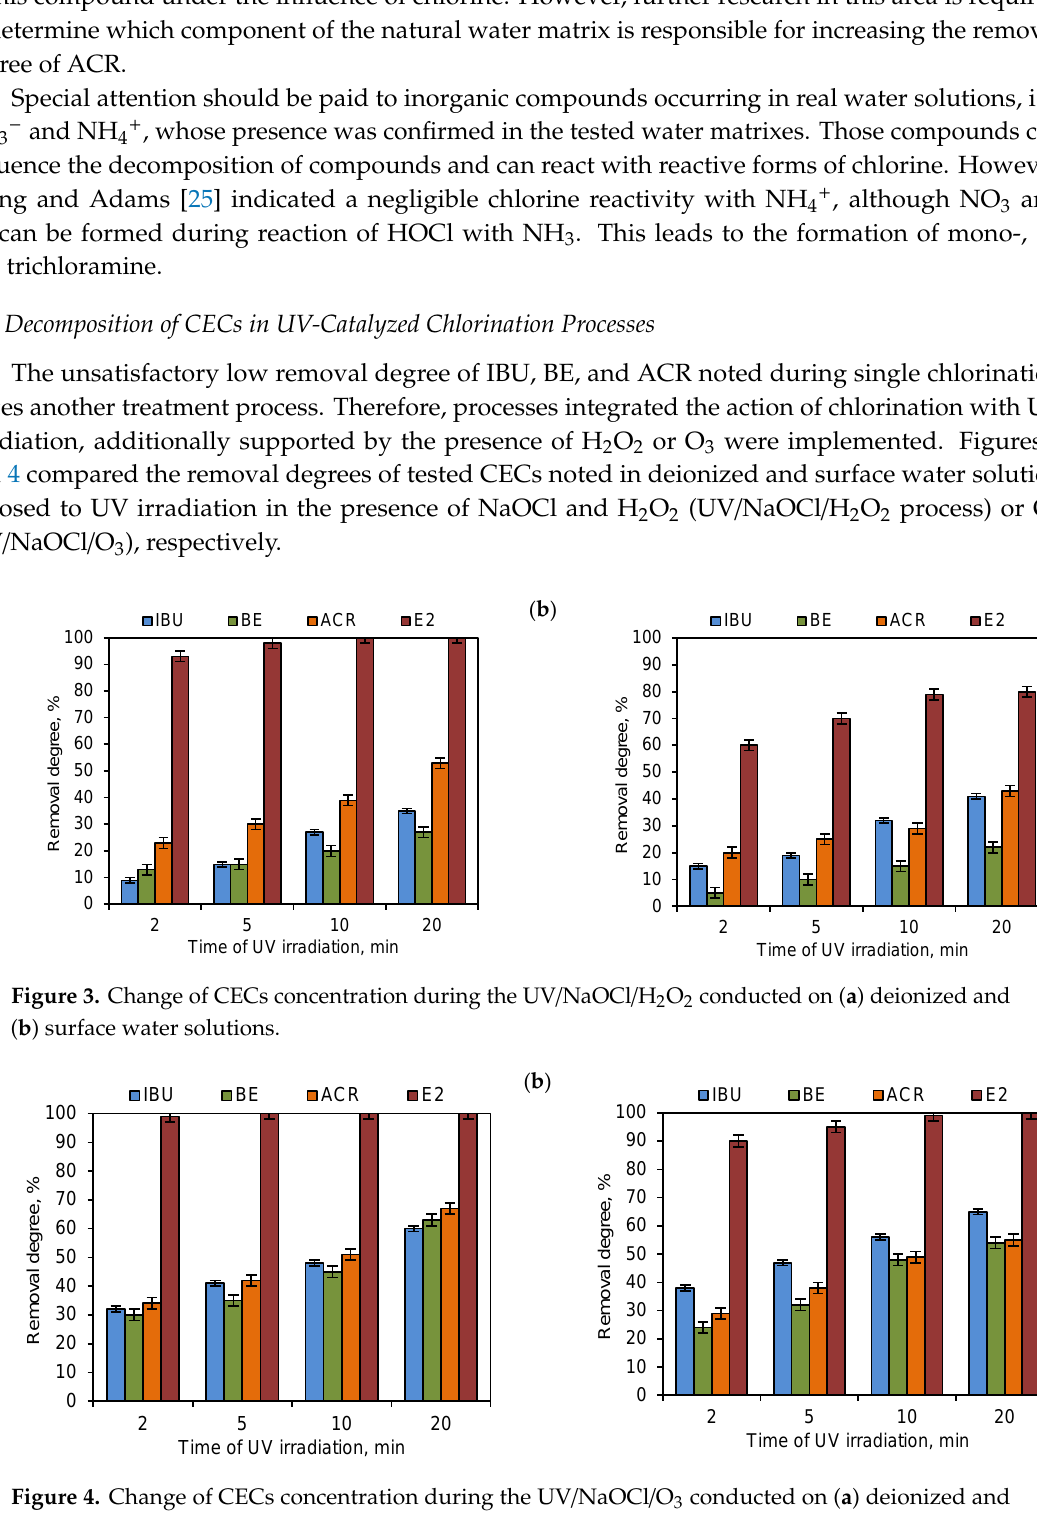
Figure 4. Change of CECs concentration during the UV/NaOCl/O 3 conducted on ( a ) deionized and ( b ) surface water solutions.